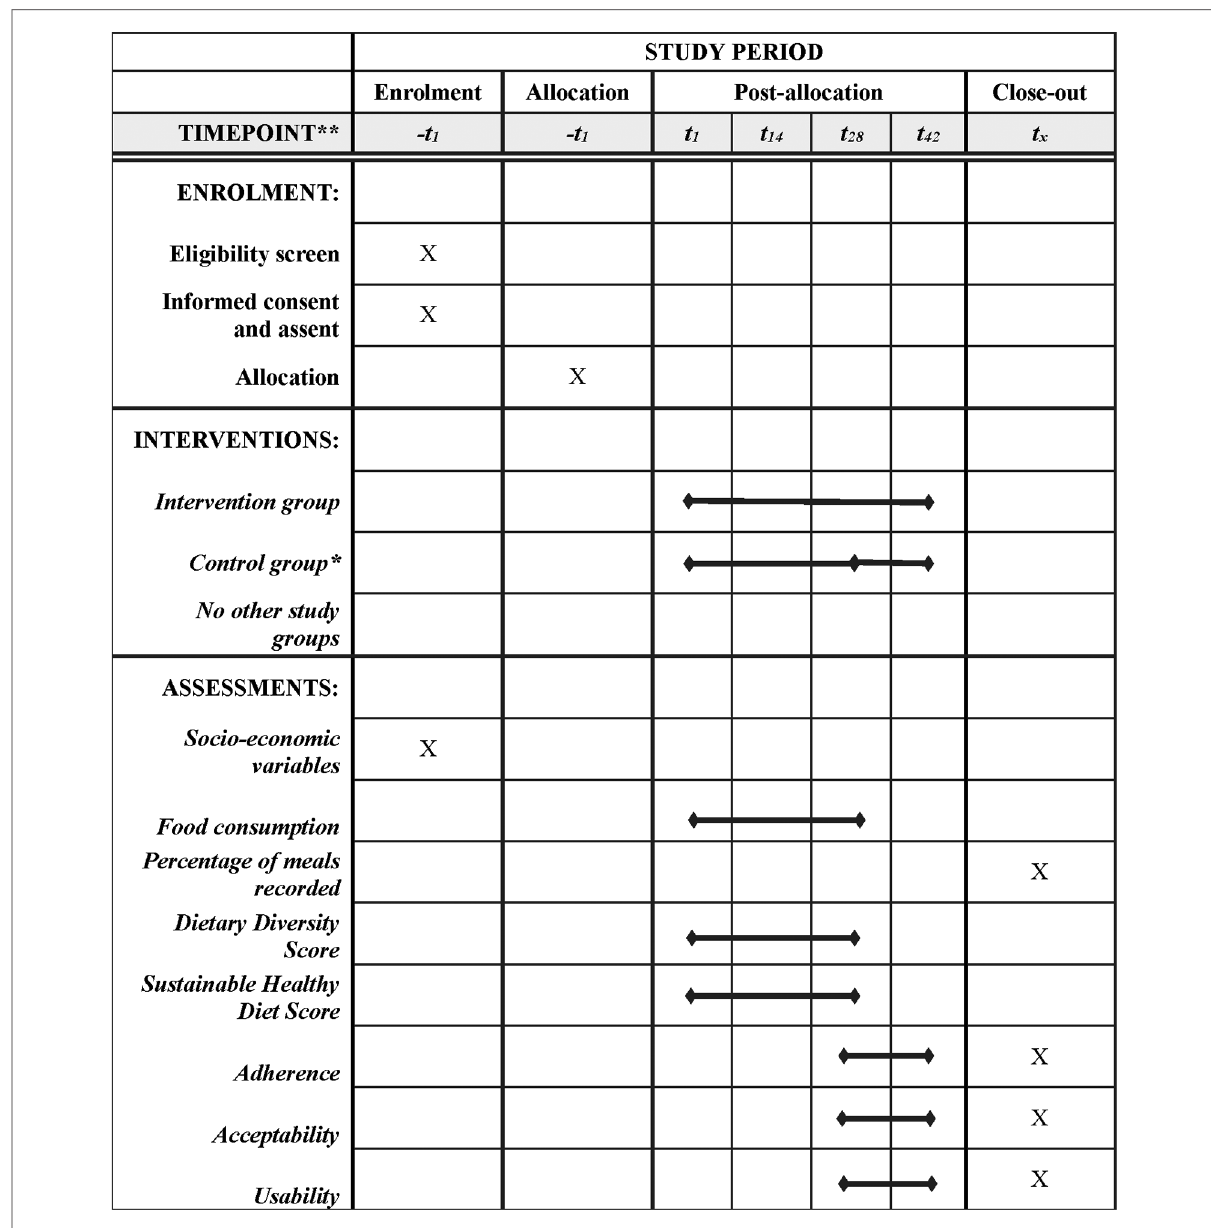
FIGURE 1 Adapted SPIRIT diagram (29). Schedule of enrolment, interventions, and assessments of the two-armed randomized controlled pilot studies in Ghana and Vietnam. *The participants in the control group will use FRANI with limited functionality to track their food choices for 28 days (4 weeks). After that, the control group will switch to also use FRANI with full functionality for the last two weeks of the post-allocation period. The bullet in t28 indicates that the control group switched for the full version